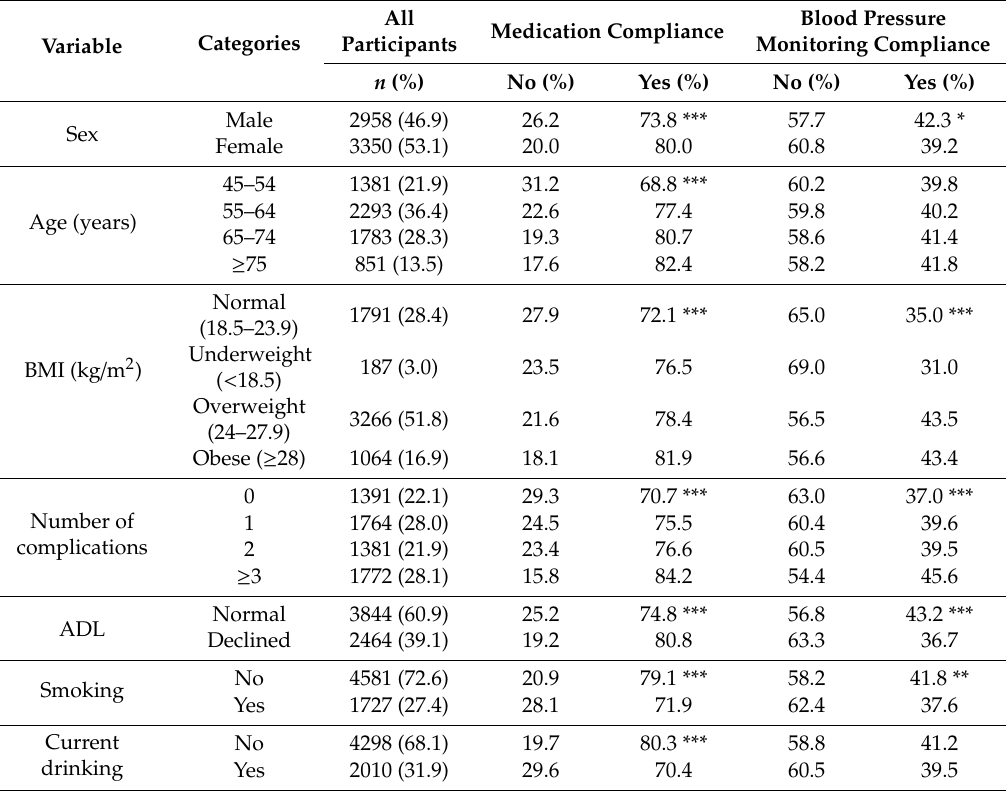
Table 1. Compliance behaviors in participants with di ff erent demographic